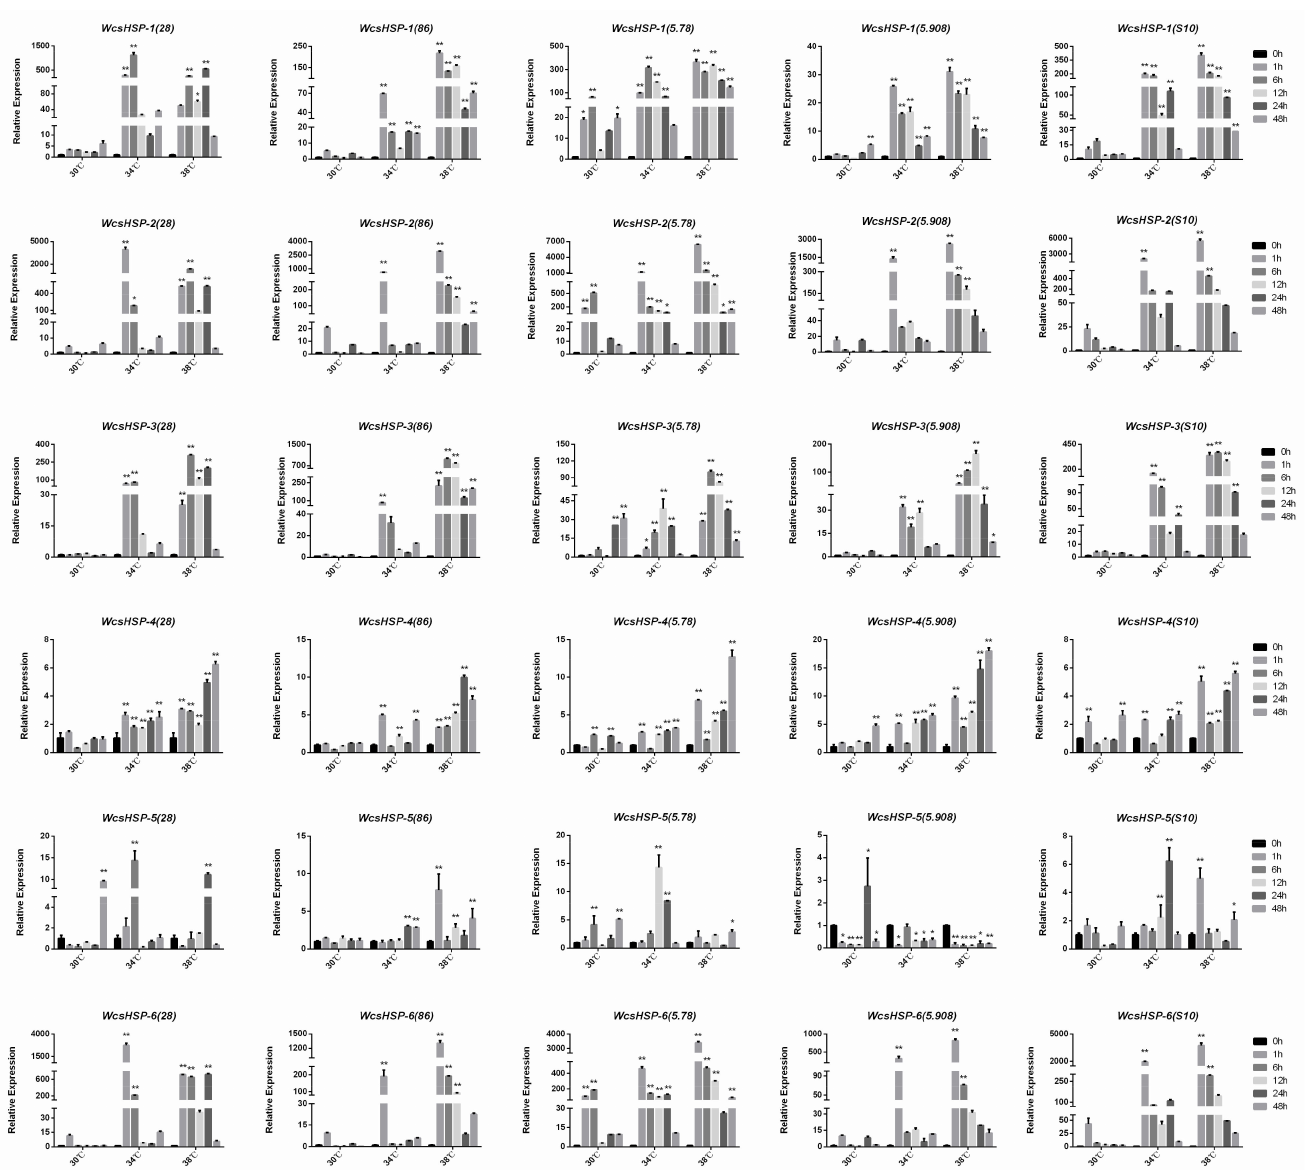
Figure 8. Analysis of expression patterns of WcsHSP gene under different temperature treatments. The different strains ‘28’, ‘86’, ‘5.78’, ‘5.908’, and ‘S10’ of W. cocos are shown. All data are means ±